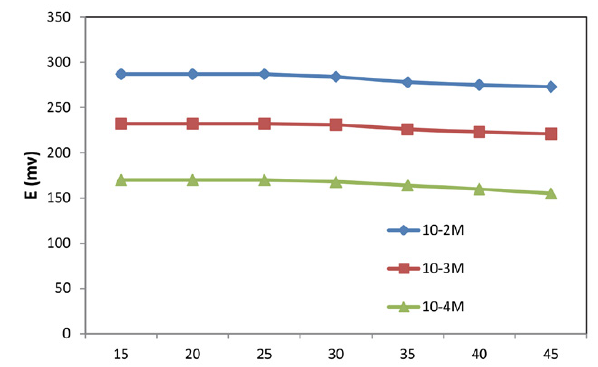
Fig. 7. Effect of temperature on the response of Lab sensor 1a